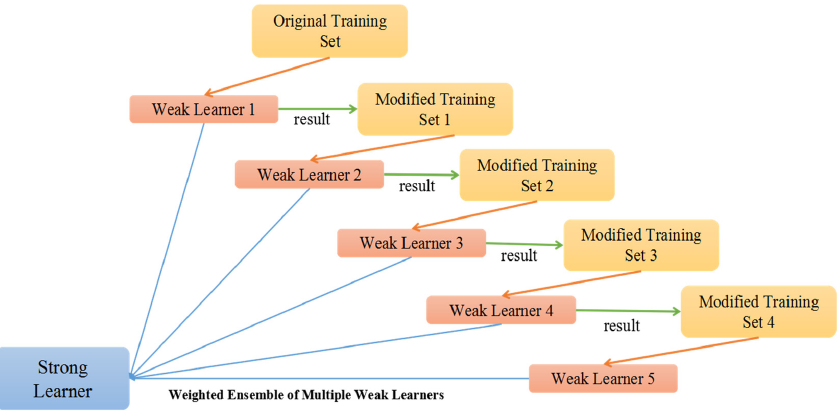
Figure 2. Flow chart of the Adaboost algorithm.